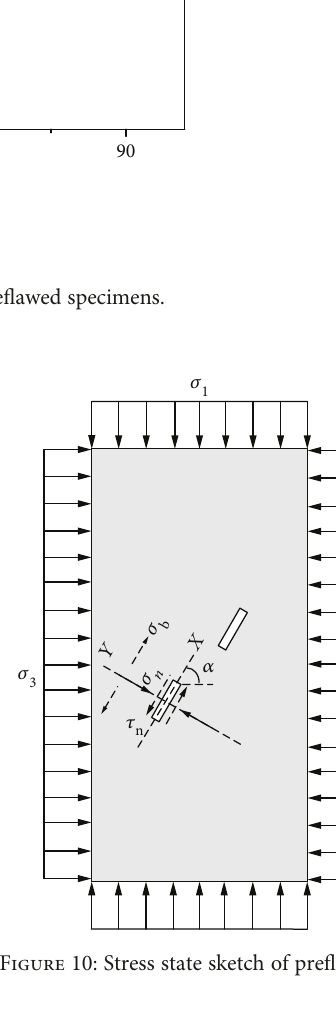
Figure 10: Stress state sketch of pre fl